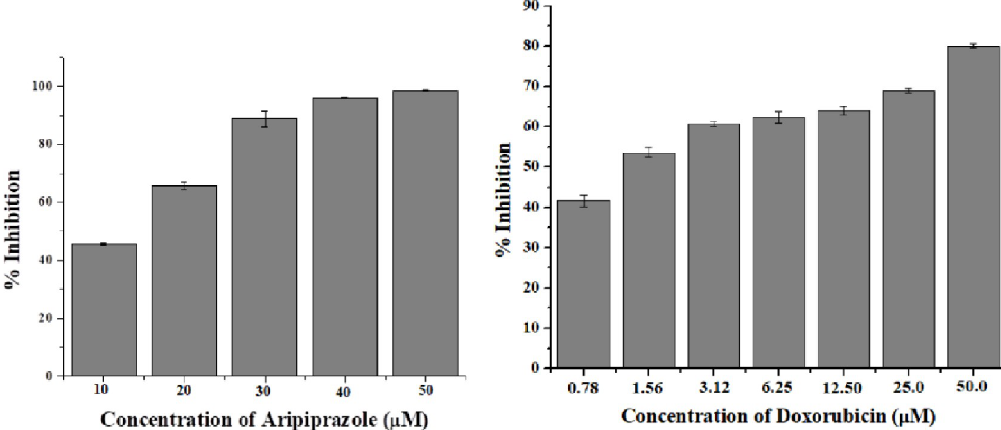
Fig 2. Graphical representation of percent inhibition of MCF-7 cell line. a) Percent inhibition of MCF-7 cells in presence of aripiprazole b) Percent inhibition of MCF-7 cells in presence of doxorubicin (standard inhibitor).